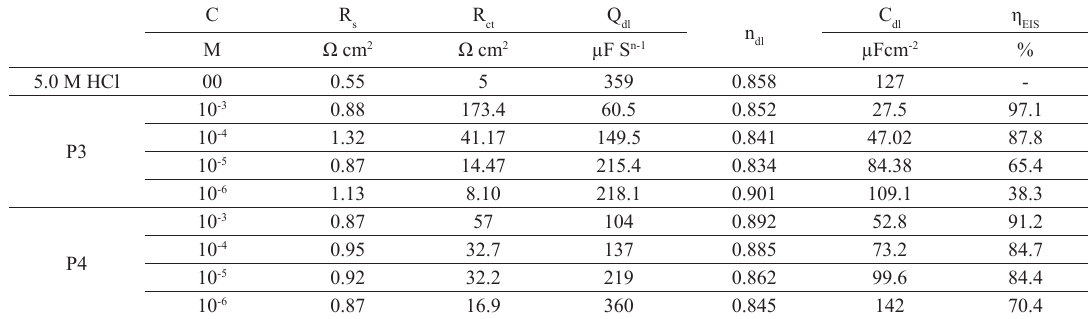
Table 3. Electrochemical impedance parameters and inhibition efficiency values for ordinary steel in 5.0 M HCl solution without and with P3 or P4 addition at different